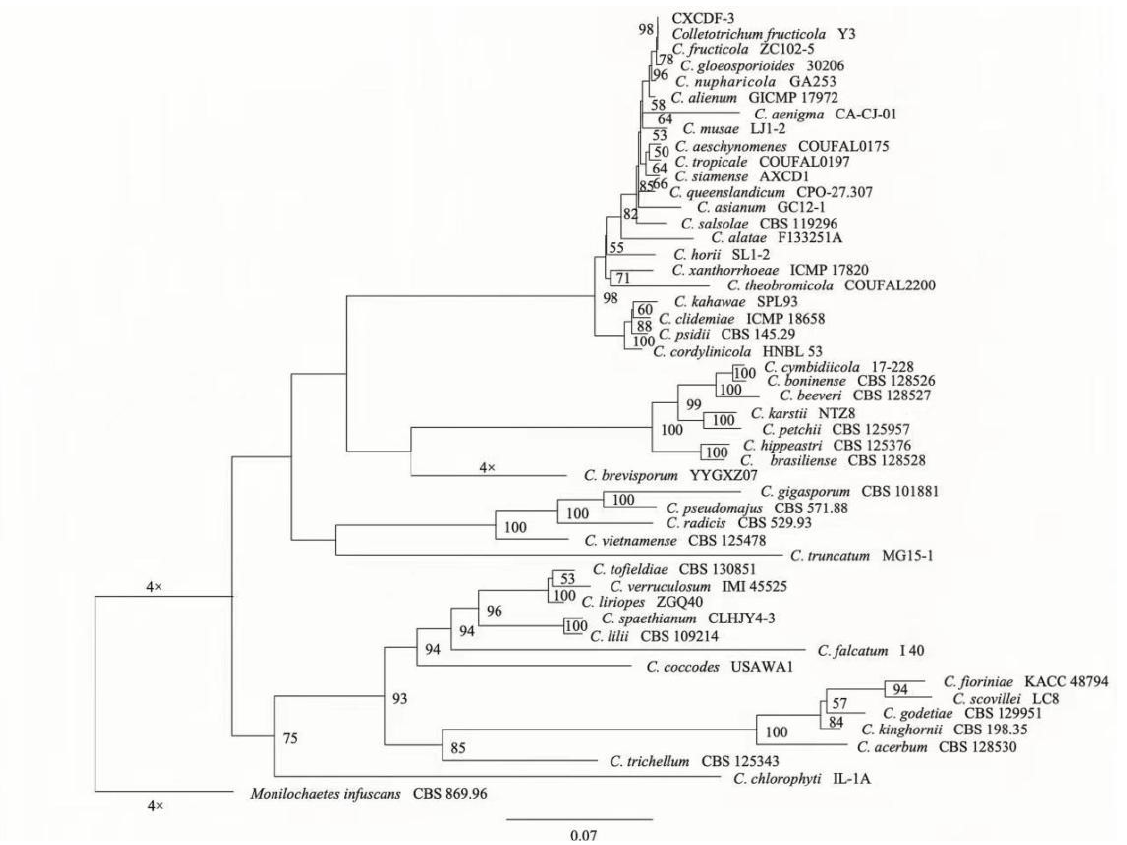
Figure 4. Phylogenetic tree of strain CXCDF-3 based on ACT–CAL–CHS–GADPH–ITS–TUB multi- gene phylogenetic analysis. Distance scale indicates the unit length of difference values between organisms or